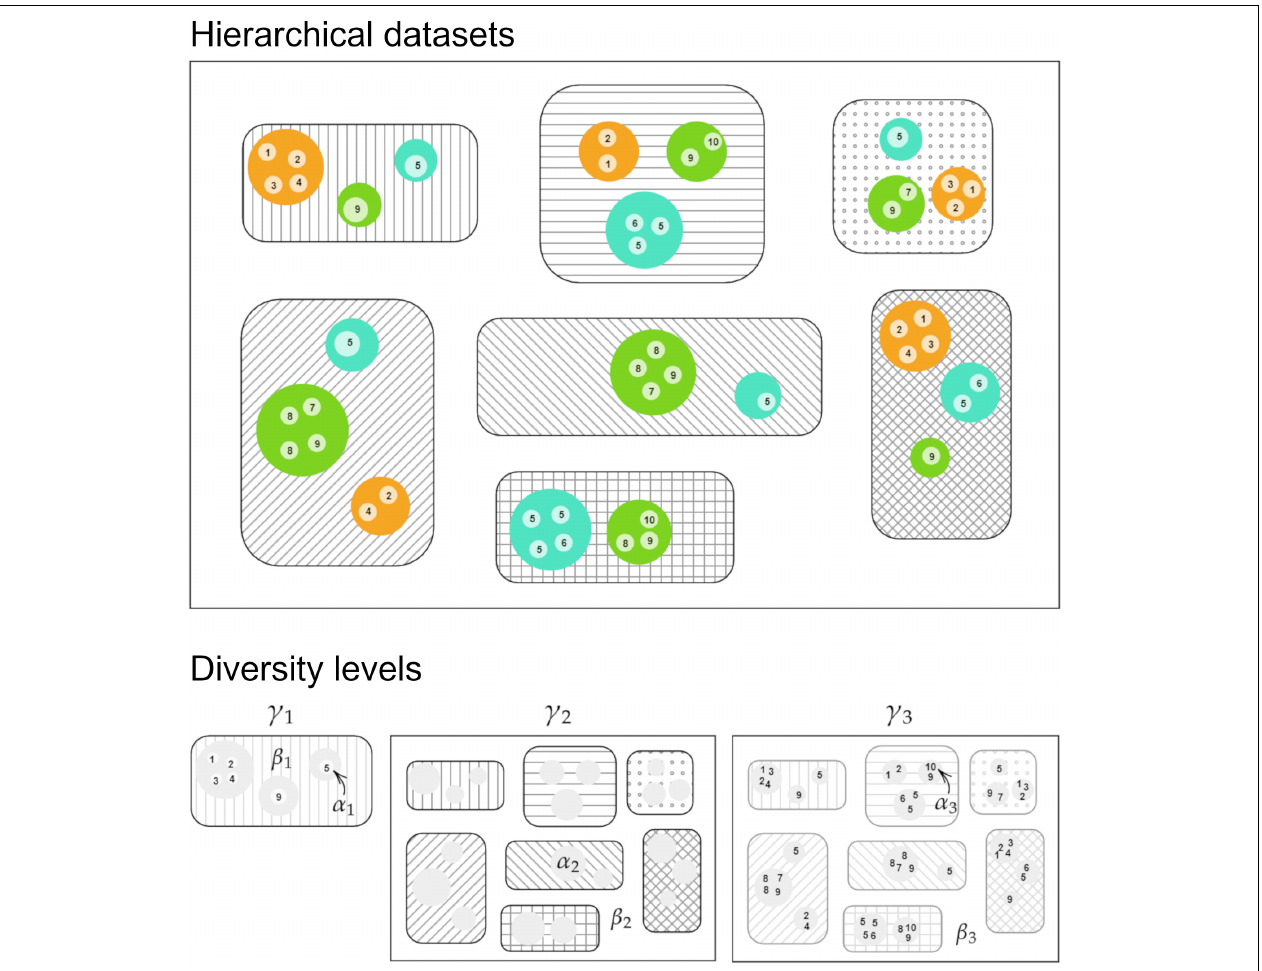
FIGURE 3 | A schematic figure showing the hierarchical datasets: sites (45 points), habitats (10 numbers), habitat types (3 circles), and localities (7 squares) and their relationship with each diversity level analyzed in this study, where α 1 ; α 3 = mean species richness at sites, β 1 = species richness across sites at localities, γ 1 ; α 2 = mean species richness at localities, β 2 = species richness across localities; β 3 = species richness across sites at the entire sample, γ 2 ; γ 3 = species richness of the entire